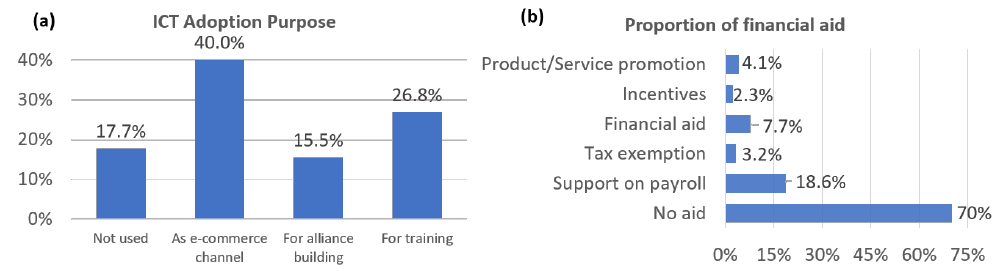
Figure 2. Sample distribution of ( a ) ICT adoption, and ( b ) proportion of received